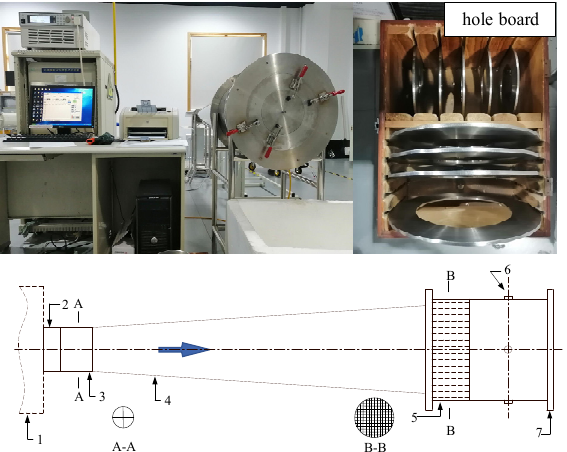
Figure 4. The aerodynamic performance experimental device of the range hood: (1) range hood; (2) pipe connector; (3) cross straightener; (4) diffusion channel; (5) cell straightener; (6) pressure taps; (7) hole board throttling device.